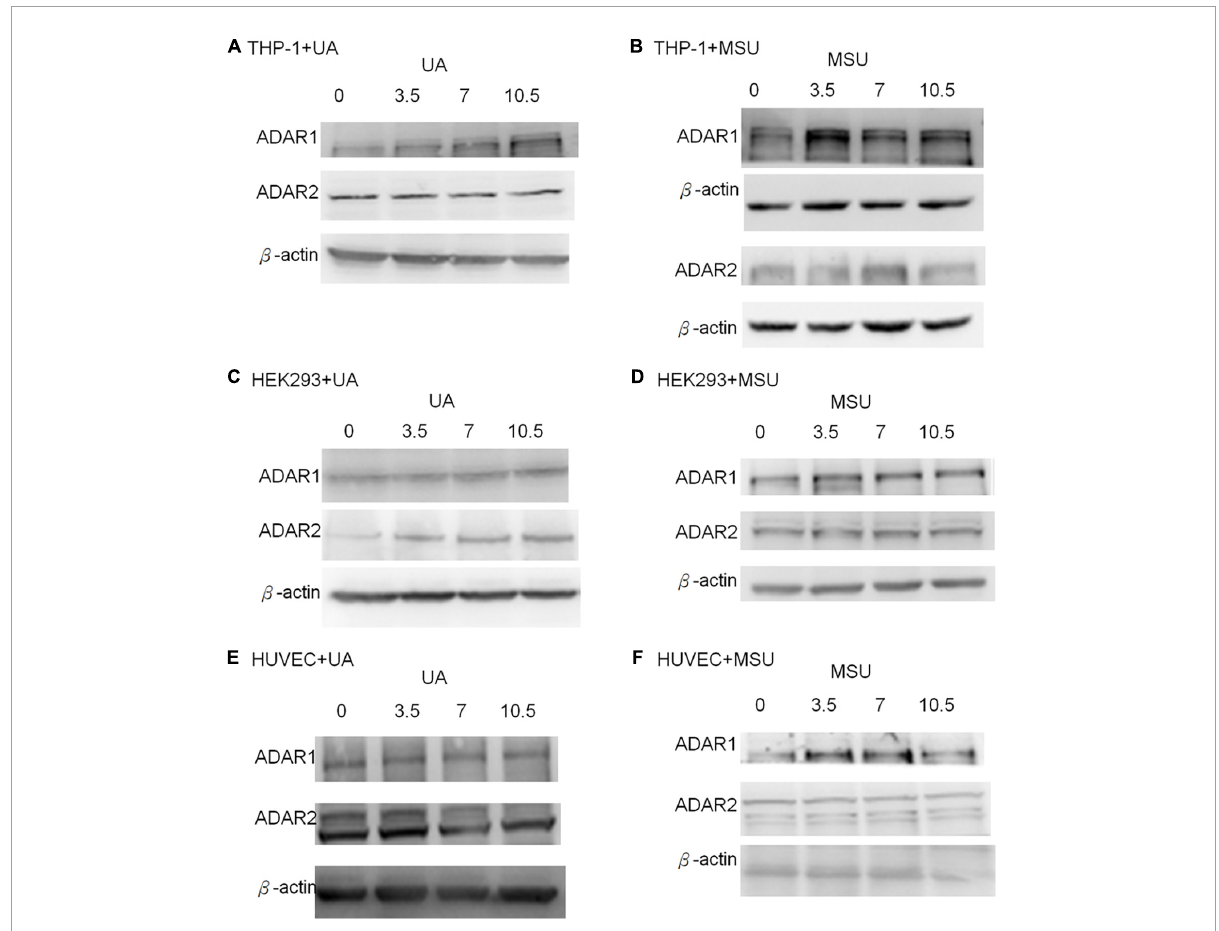
FIGURE4 Protein expressions of RNA editing enzymes were affected in MSU- or UA-treated cell lines. The expressions of ADAR1 and ADAR2 were detected through Western blotting in UA-treated THP-1 cells (A) , MSU-treated THP-1 cells (B) , UA-treated HEK293 cells (C) , MSU-treated HEK293 cells (D) , UA-treated HUVEC cells (E) , and MSU-treated HUVEC cells (F) . β -actin served as the internal control. Representative results from three independent experiments are